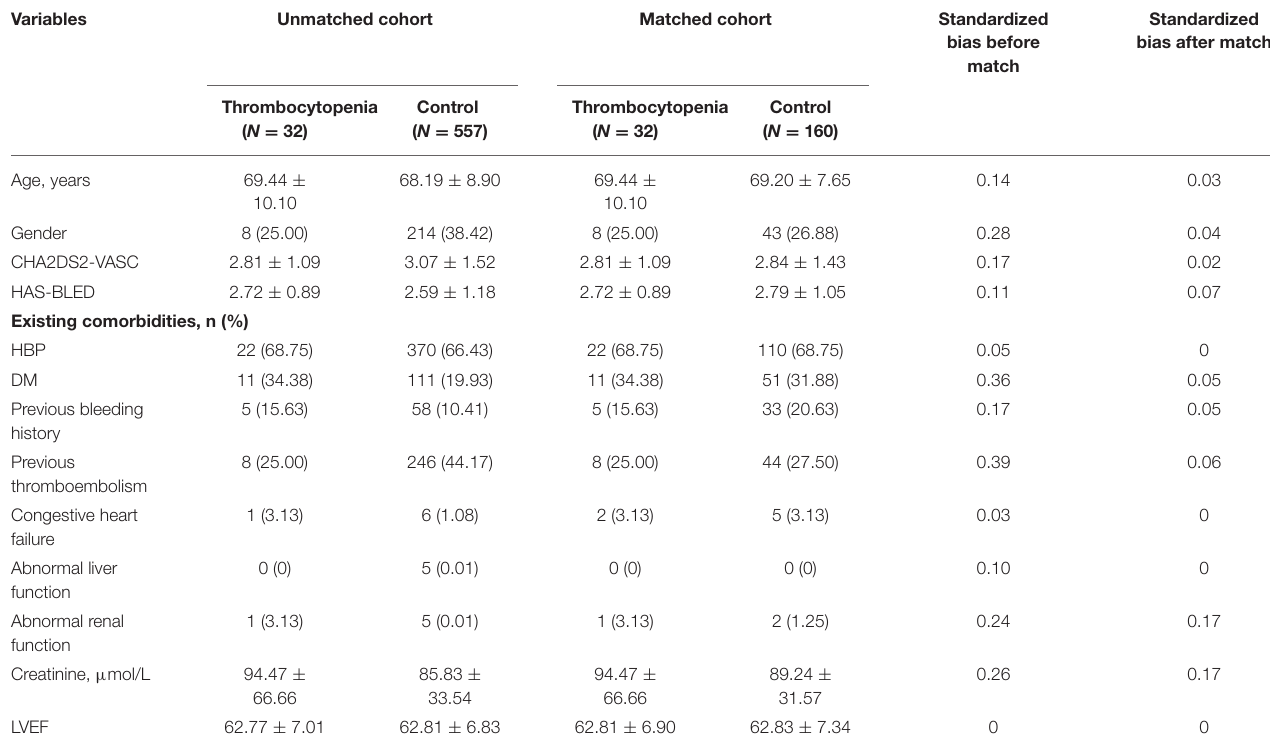
TABLE 1 | Baseline patient characteristics before and after matching.